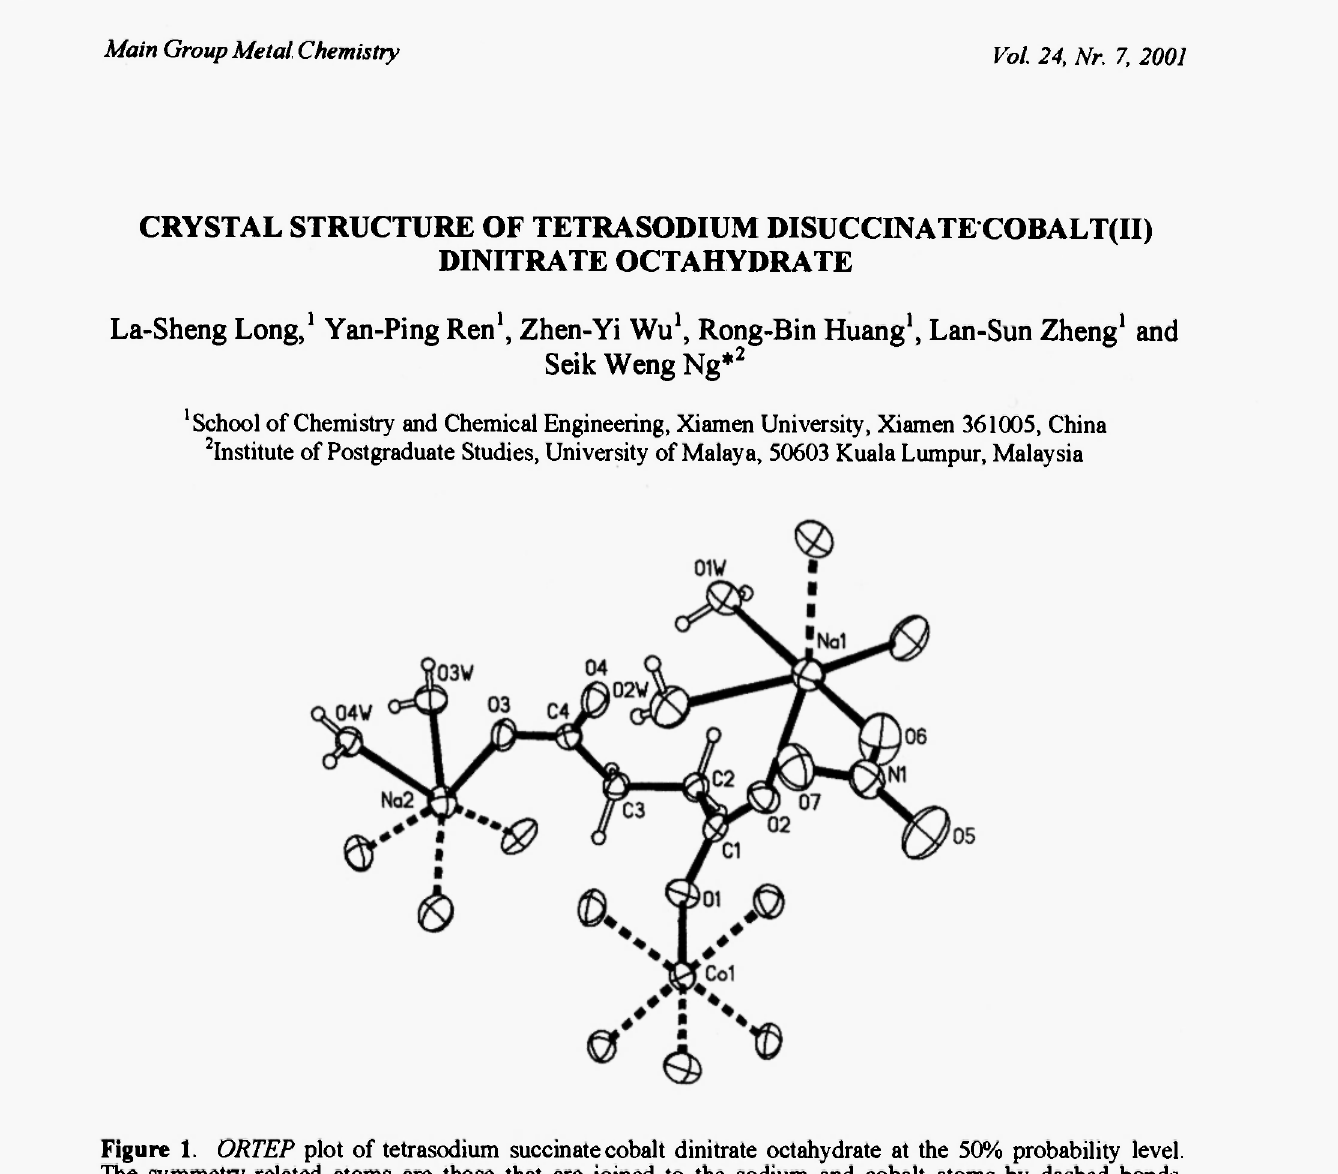
Figure 1. ORTEP plot of tetrasodium succinate cobalt dinitrate octahydrate at the 50% probability level. The symmetry-related atoms are those that are joined to the sodium and cobalt atoms by dashed bonds. Selected bond distances and angles: Nal-02 = 2.387(2), Nal-06 = 2.527(2), Nal-06" = 2.541(2), Nal- OLW = 2.427(2), Nal-Olw 8 = 2.379(2), Nal-02w = 2.572(2), Na2-03 = 2.375(2), Na2-05 b = 2.382(2), Na2-07° = 2.406(2), Na2-02w c = 2.434(2), Na2-03w = 2.419(2), Na2-04w = 2.398(2), Col-Ol = 2.090(2), Col-03 c = 2.089(2), CO1-04H- c = 2.139(2) A; 02-Nal-06 = 98.7(1), 02-Nal-06" = 91.2(1), 02-Nal-02w = 74.7(1), 02-Nal-0lH> = 90.7(1), 02-Nal-01w f = 163.2(1), 06-Nal-06" = 65.7(1), 06-Nal-01w>